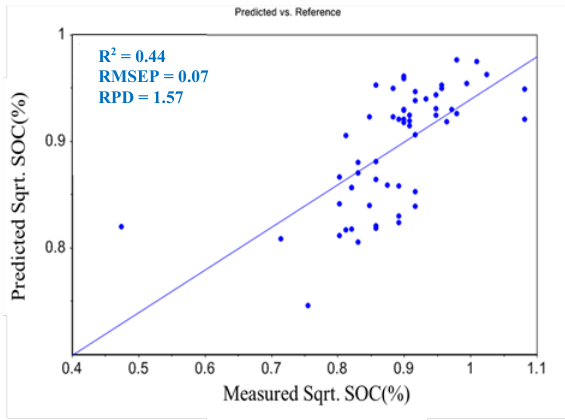
Figure 5. Scatter plot of SOC in validation dataset The prediction capability of the spectral model for the prediction of any soil parameter depends on the relationship of that parameter with spectrally active compounds like clay,